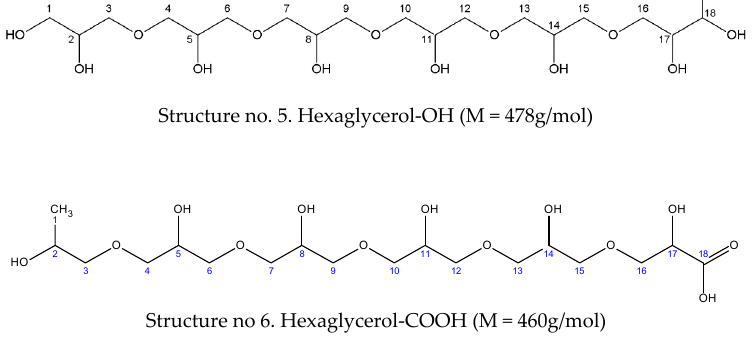
Figure 4. Examples of typical and non-typical structures of oligoglycerols.